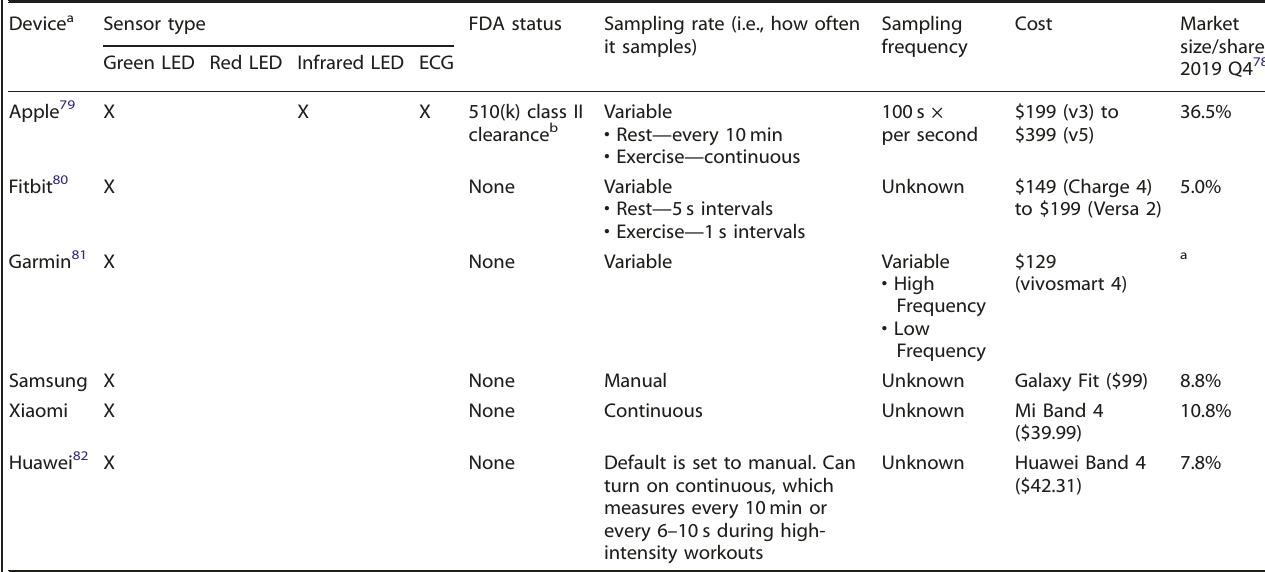
Table 1. Summary of most popular consumer wearable